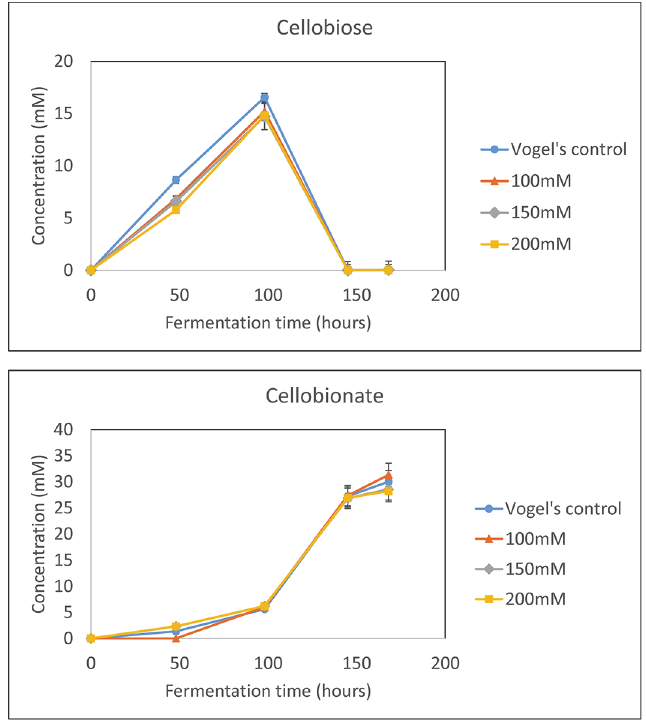
Fig 3. The effect of potassium phosphate buffer concentration and the conversion of cellobiose to CBA via CDH-ABTS-laccase mediated conversion with the F5 Δ ace-1 Δ cre-1 Δ ndvB strain in 1x Vogel ’ s medium and 20 g/L Avicel. The values shown are the means of biological duplicates with the error bars representing the standard deviations.